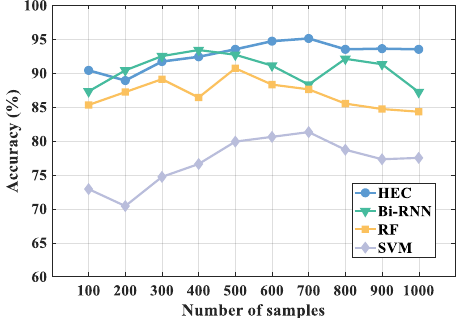
Figure 16. Impact of different sample sizes.